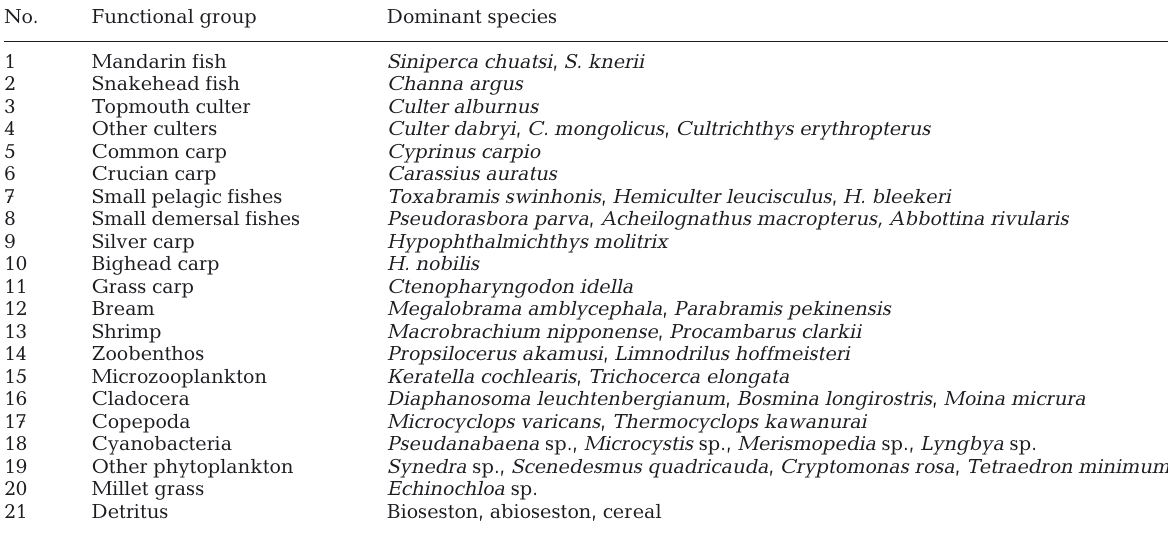
Table 2. Functional groups and dominant species composition of Lake Shangshe in the